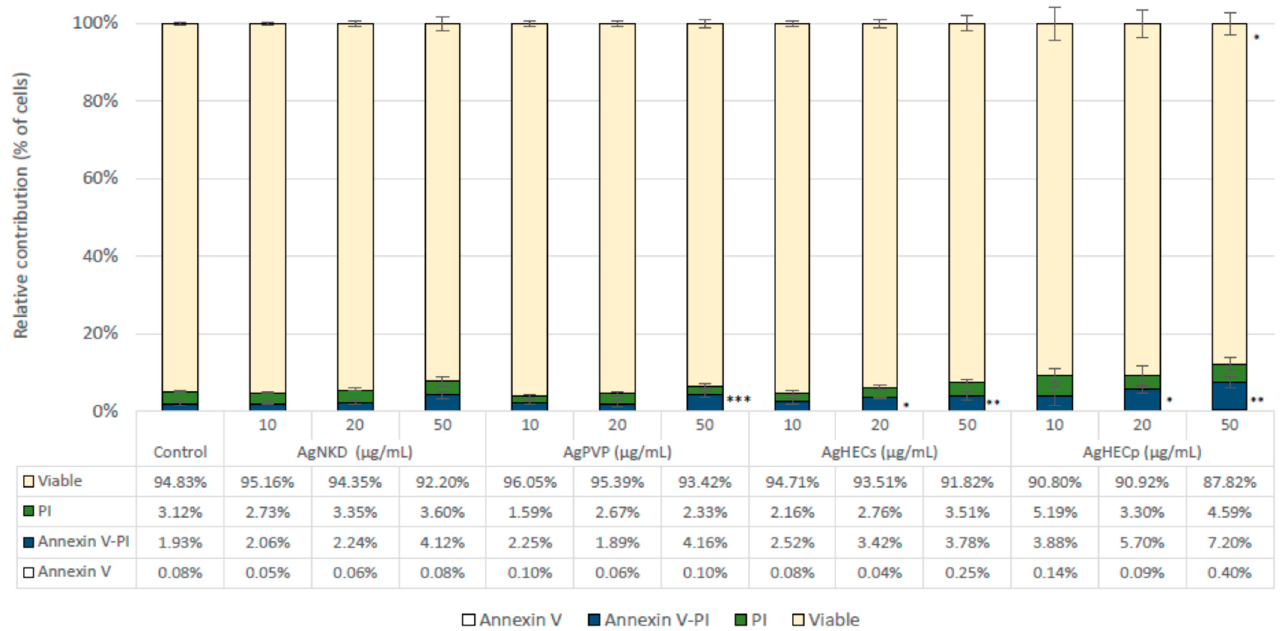
Figure A4. Cell death characterization after exposure to Ag NPs. The percentages of viable cells, apoptotic cells (Annexin V positive), late apoptotic cells (Annexin V/PI—positive) and necrotic cells (PI—positive). A549 cells after exposure for 24 h to 50 µg/mL to Ag NPs; each treatment is reported with its relative negative control (unexposed cells). Statistical analysis: one-way ANOVA followed by t-test; * p < 0.05; ** p < 0.01, *** p < 0.001 compared to control cells. N = 3.